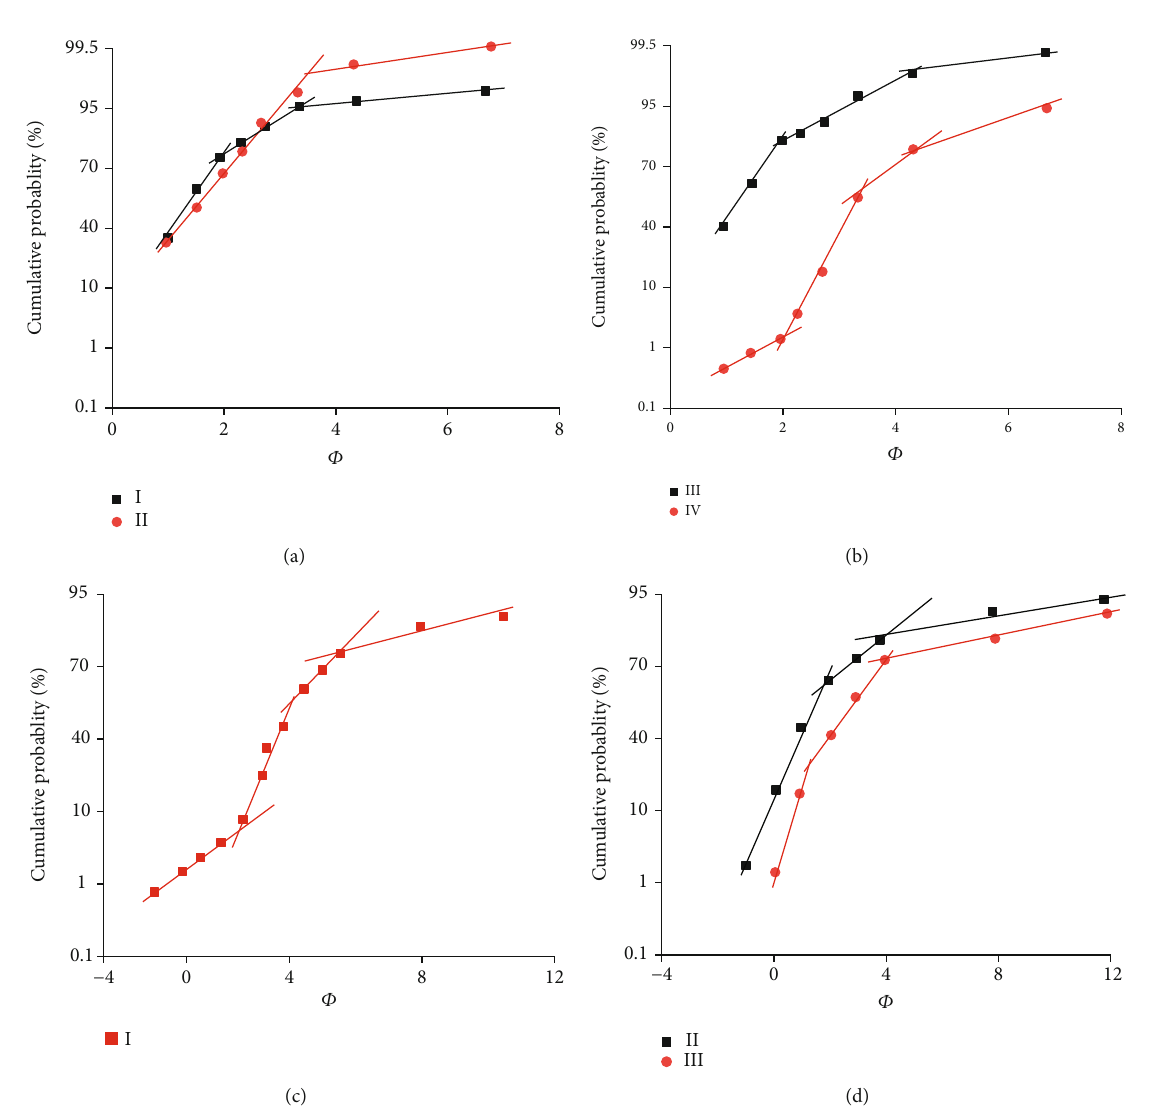
Figure 12: Grain size probability accumulations of di ff erent sedimentary microfacies [37]. Table 5: Grain size interval of di ff erent sedimentary